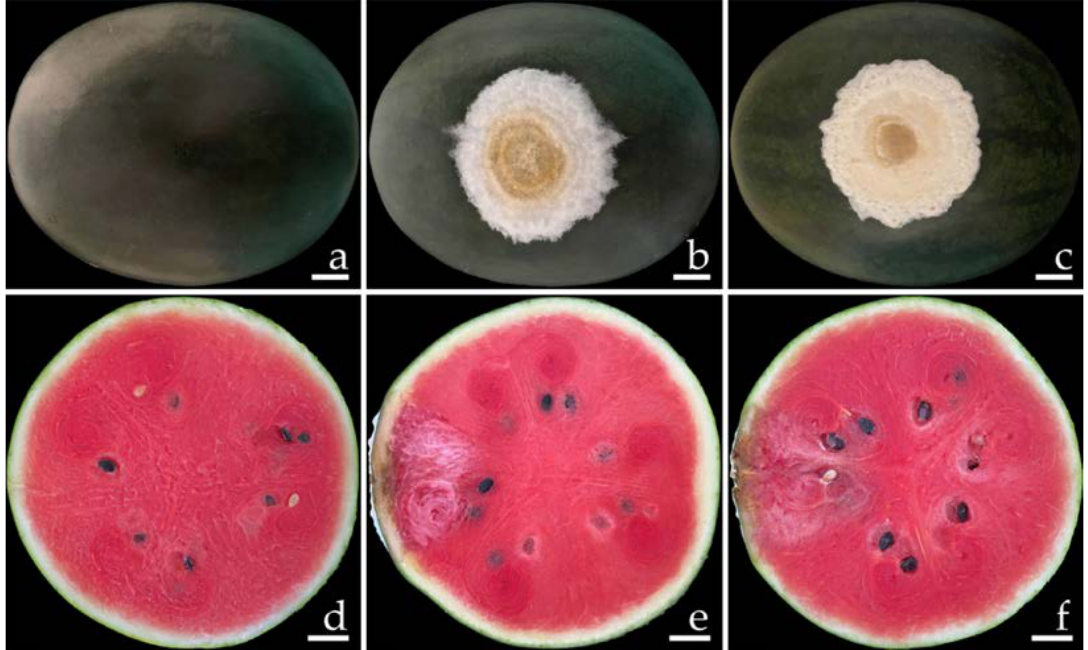
Figure 6. Pathogenicity test with F. compactum SDBR-CMU461 and SDBR-CMU462 on watermelon fruits after seven days of inoculation. Control fruit inoculated with sterile water ( a , d ); and disease symptoms after inoculation with isolate SDBR-CMU461 ( b , e ) and isolate SDBR-CMU462 ( c , f ). Scale bars = 20 mm.